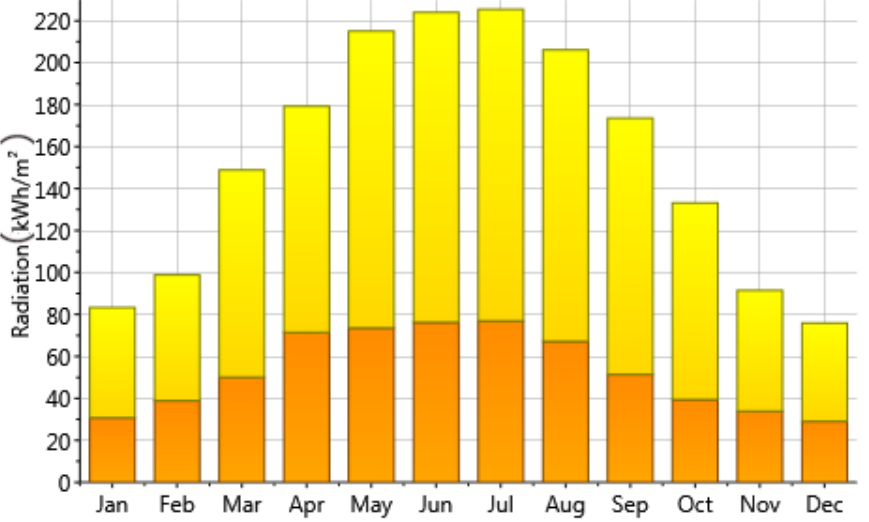
Figure 11. Tehran solar